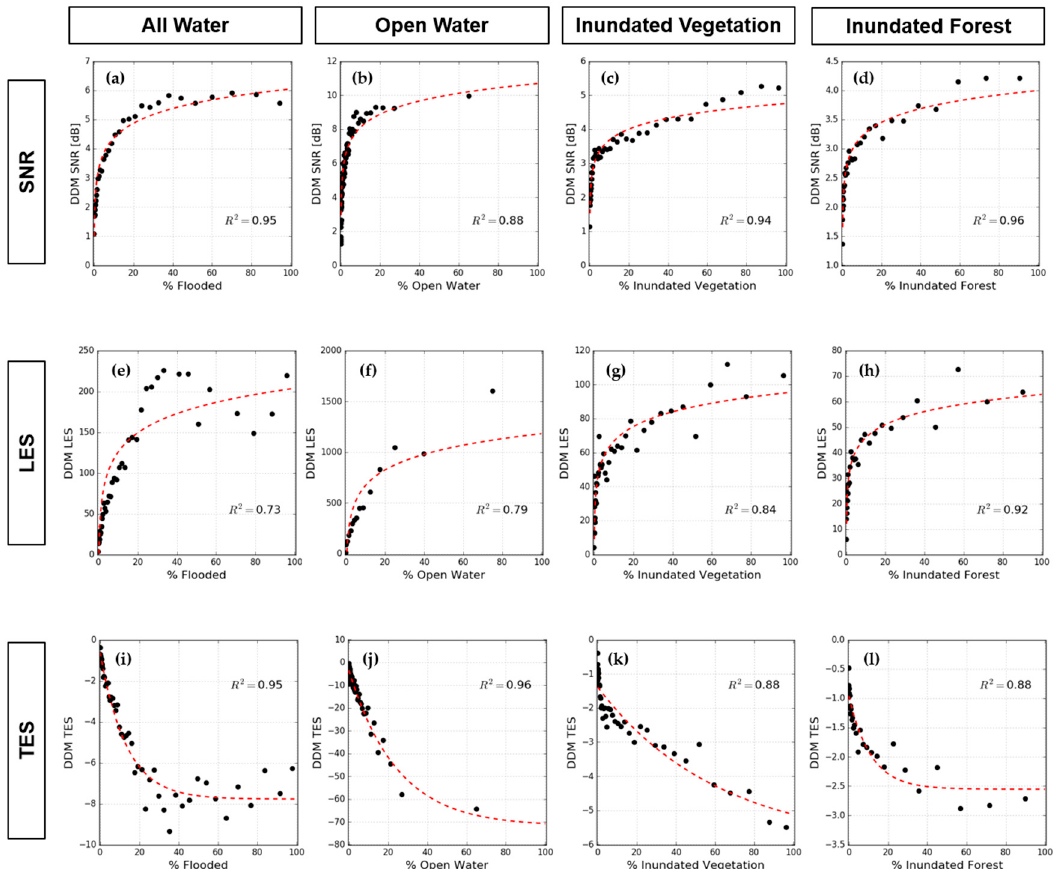
Figure 14. CYGNSS footprint flooded area percentage estimated with classified PALSAR-2 mosaics vs. CYGNSS DDM observations, including SNR in top row ( a – d ), LES in center row ( e – h ), and TES in bottom row ( i – l ). Leftmost column displays all footprints, where % flooded counts flooded area regardless of vegetation (Open Water, Inundated Non-Forest, and Inundated Forest). The center left column presents the subset of the CYGNSS footprints with negligible inundated vegetation (Inundated Non-Forest and Inundated Forest of less than 5%), focusing only on the percentage of Open Water in each footprint. The center right column displays the subset of footprints with negligible Open Water (<1%) and displays the percentage of inundated vegetation (either Inundated Non-Forest or Inundated Forest). The rightmost column shows the subset of footprints with negligible Open Water or Inundated Non-Forest (<1%) and displays the percentage of Inundated Forest. Median values of DDM values are displayed in black, derived from bins of equal size ( n =